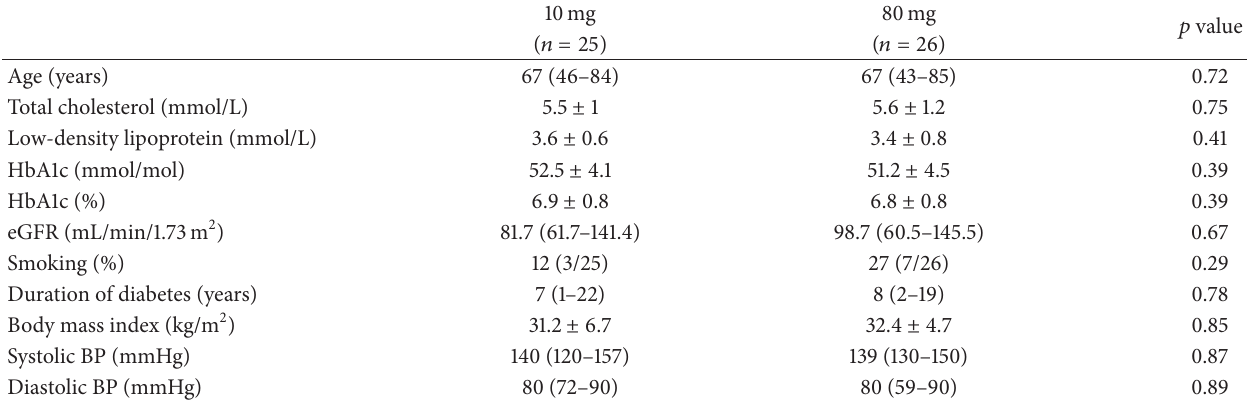
Table 1: Baseline characteristics of the study cohort, divided into 10 and 80 mg groups.